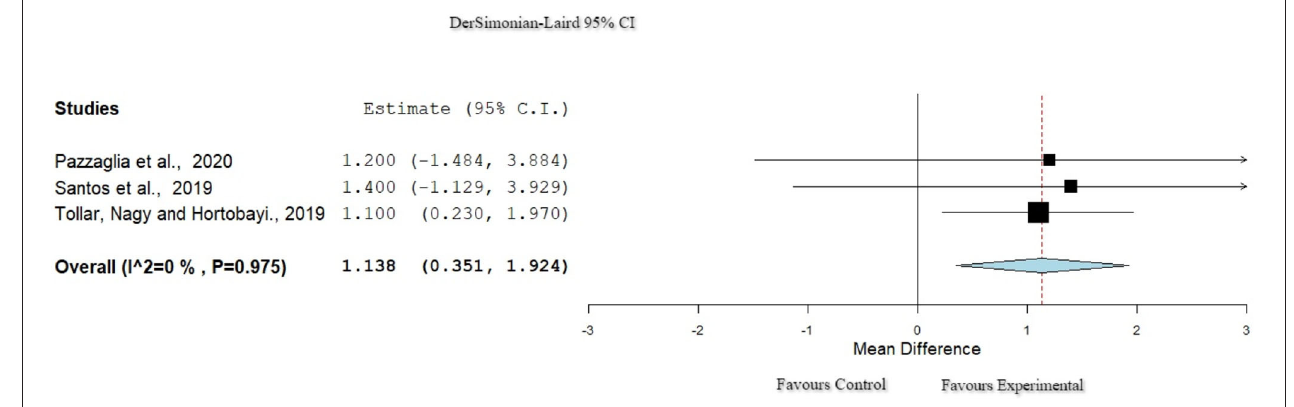
FIGURE 7 | Forest plot for Function: DGI. The red dash line represents the weighted mean difference of the included studies. The blue figure represents the weighted 95% CI of the included studies. DGI, Dynamic Gait